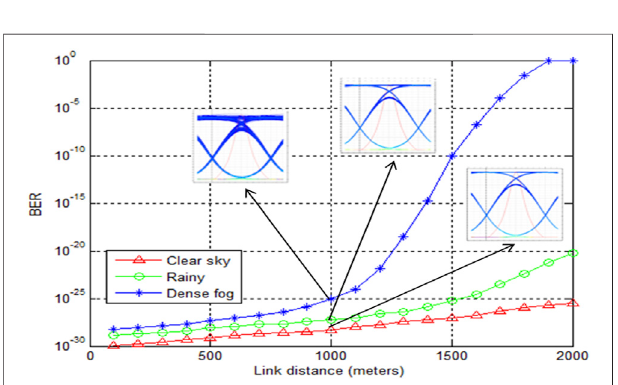
FIGURE 7 | Graph of SNR v/s transmitted power for different atmospheric conditions.